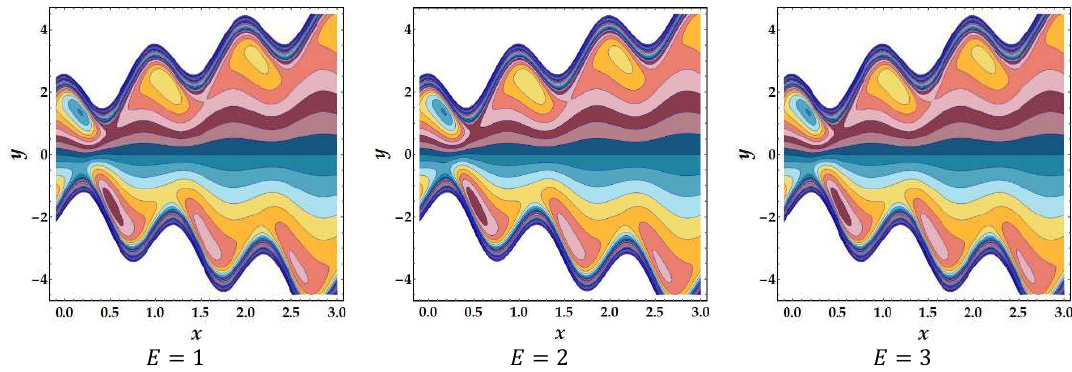
Figure 12. The behavior of Streamlines for different values of electric field E .